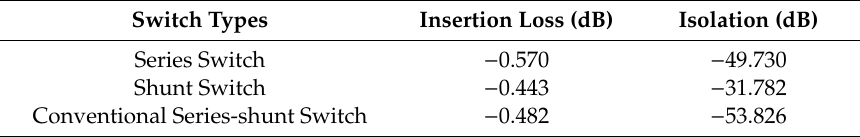
Table 3. Comparison of insertion loss and isolation for different Switches.